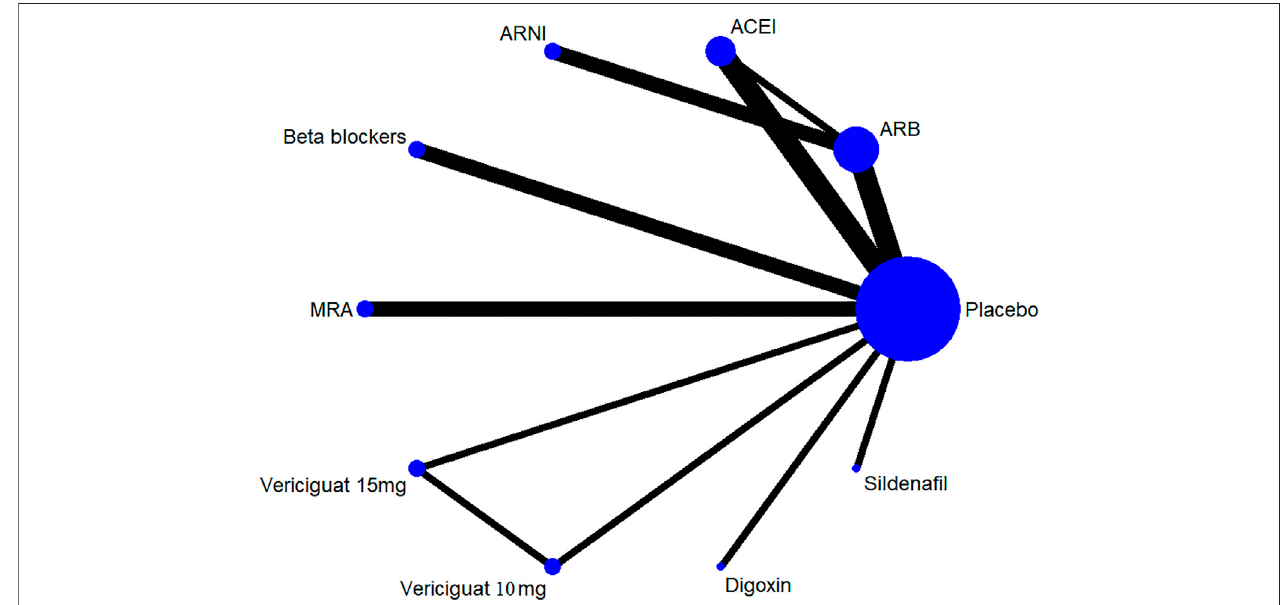
FIGURE 1 | Flow diagram of the study selection process. HF, heart failure; MRA, mineralocorticoid receptor antagonist; SLGT2, sodium-glucose cotransporter-2.